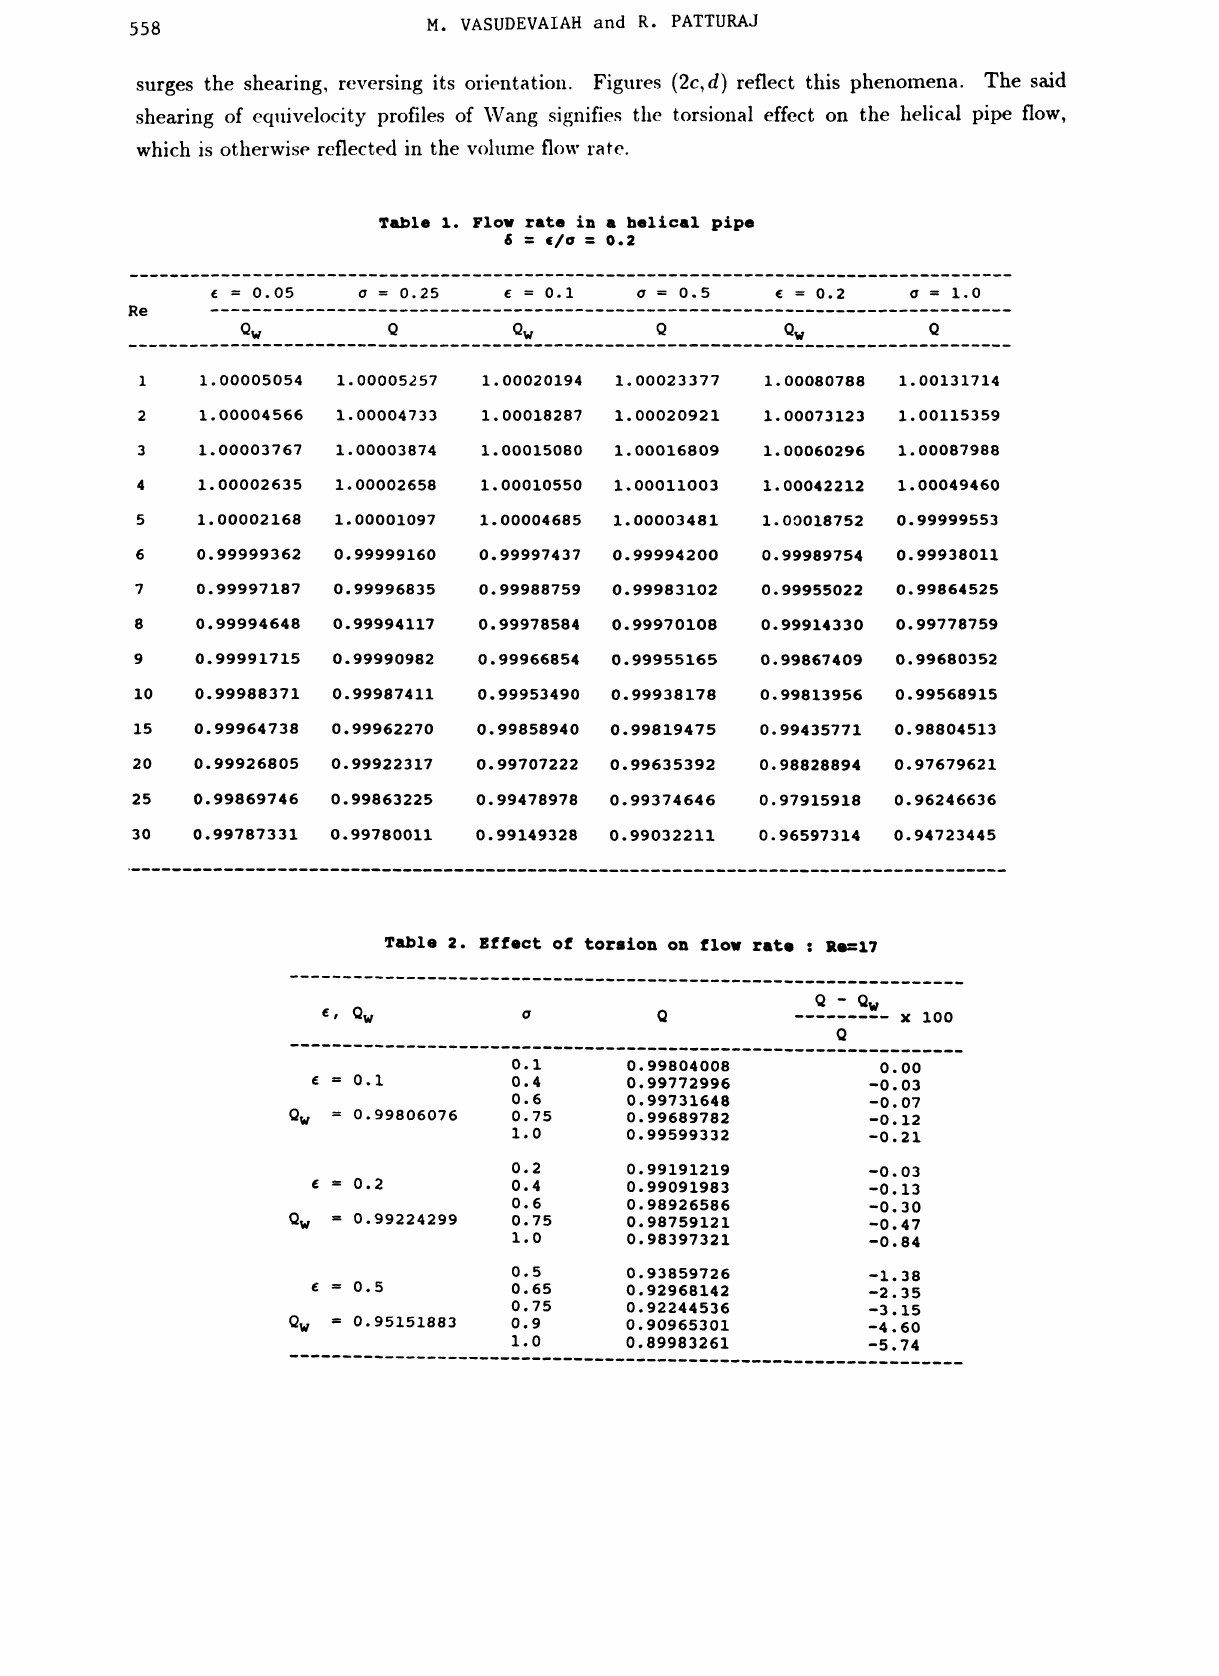
Table 2. Effect of torsion on flow